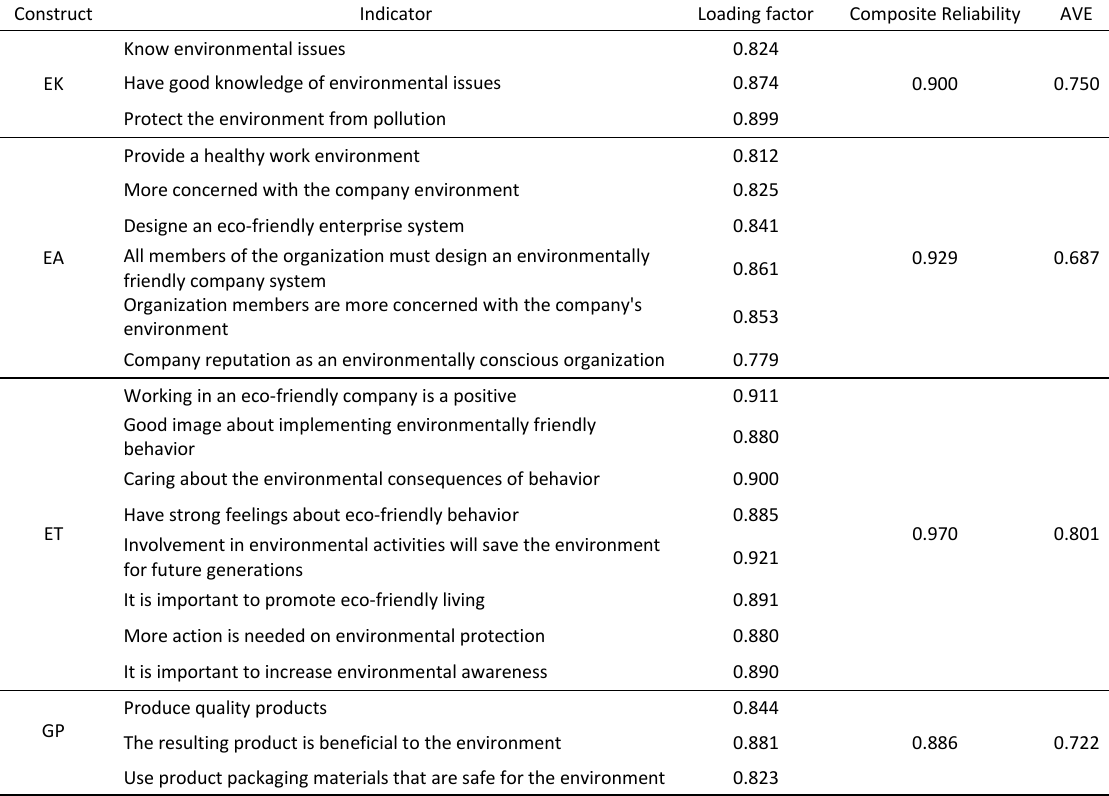
Table 2: Assesment result of measurement model